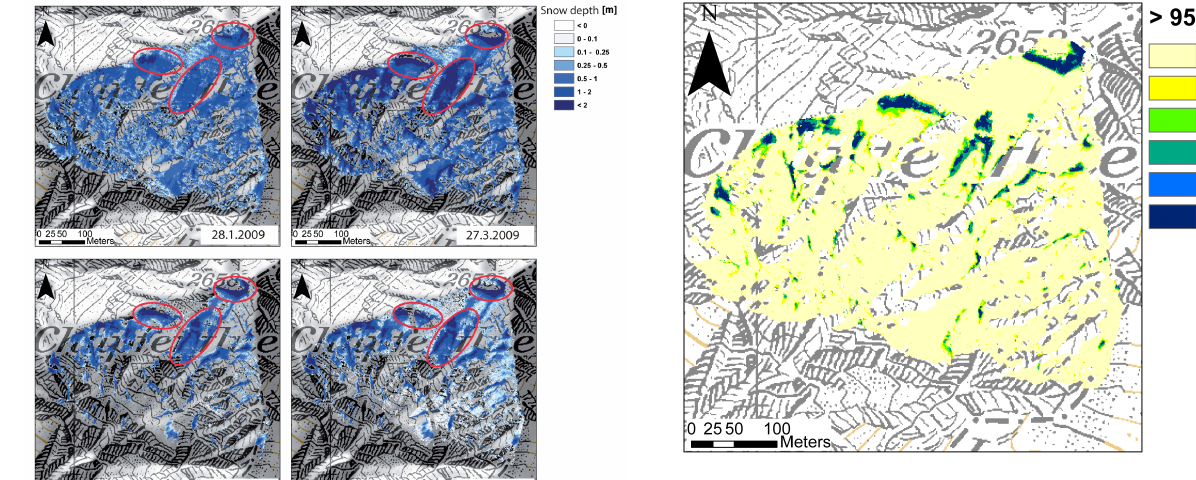
Fig. 6. Frequency of cells with highest HS per observation day over the winter 2008/2009. The frequency shows how often a cell had a HS within the range of HS of 5% of the cells with the highest HS of this observation day (calculated based on a cumulative histogram of HS per observation day). A value of one means that a cell had on all observation days a HS within the range of HS of the 5% of cells with the highest HS of this observation day.